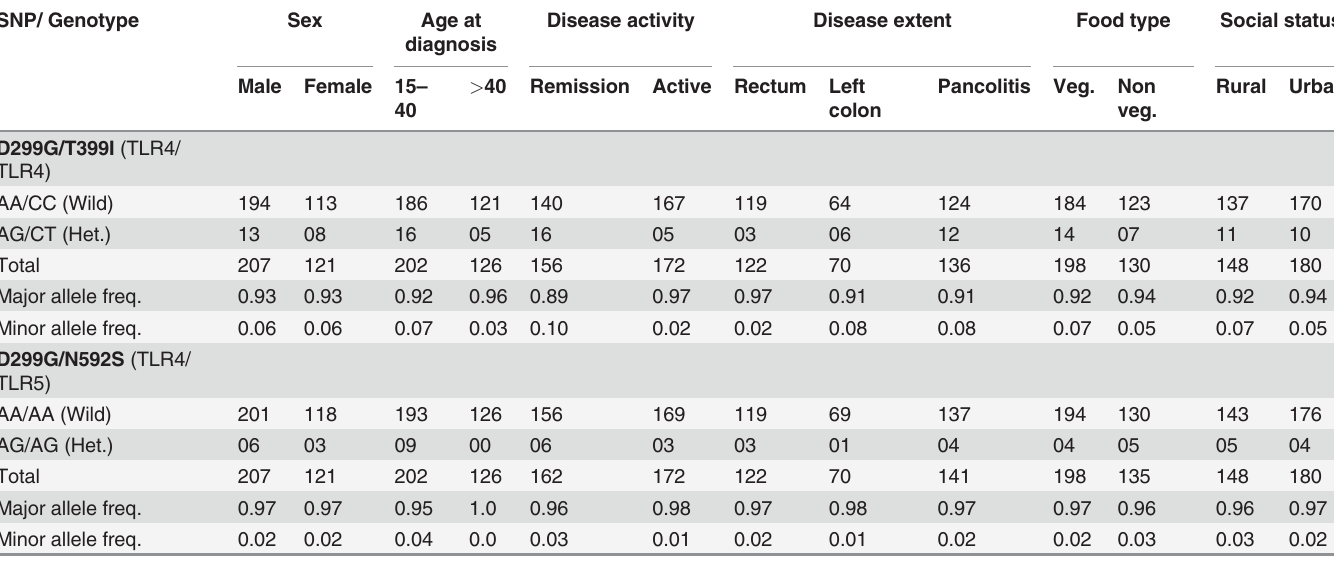
Table 4. Genotype and allele frequencies of D299G/T399I and D299G/N592S combinations in UC cases strati fi ed by